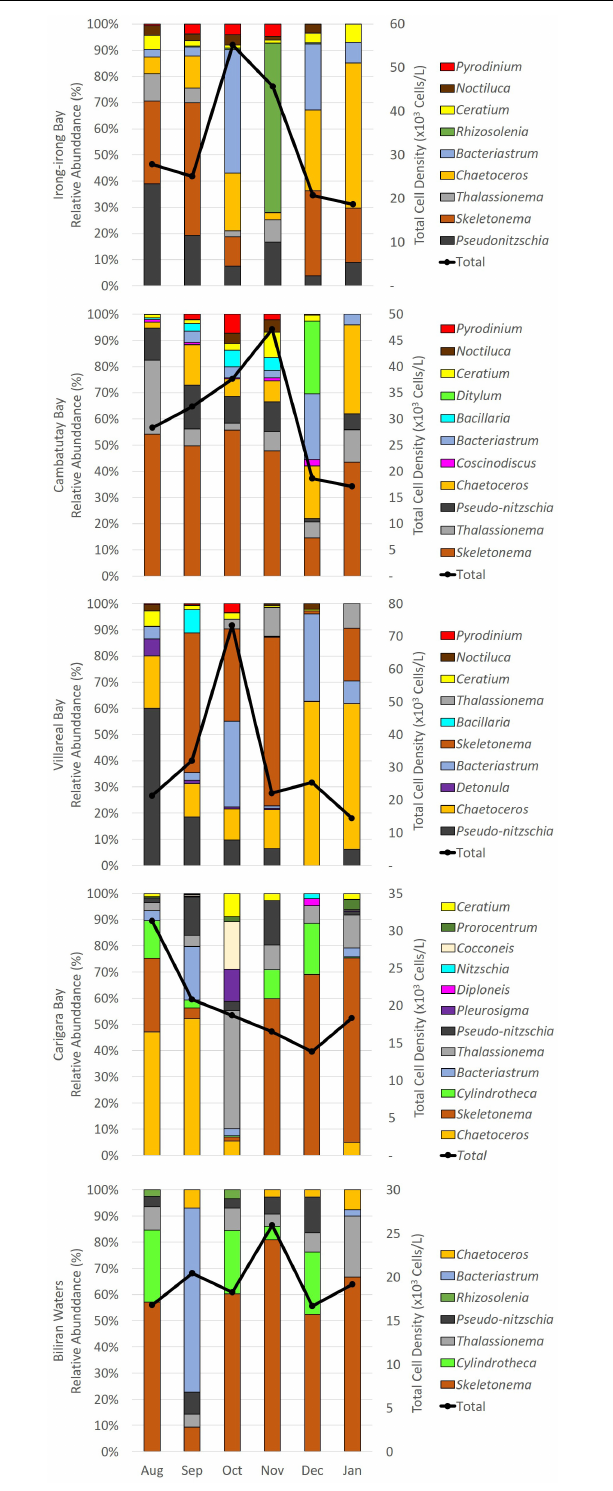
FIGURE 4 | Mean relative abundances (%) of the dominant phytoplankton taxonomic groups found in each sampling site in Eastern Visayas, Philippines from August 2020-January 2021 and the corresponding total average phytoplankton densities in 10 3 cells L − 1 .